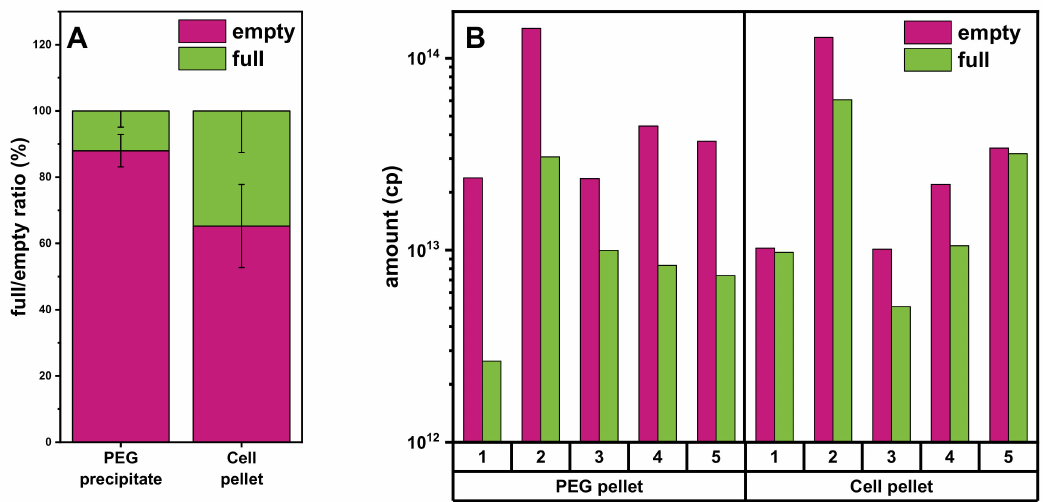
Figure 6. Assessment of the full/empty ratios from the PEG precipitate or cell lysate using analytical AEX chromatography. ( A ) Graph showing the full rAAV (light green) and empty capsid (purple) titer ratio determined using analytical AEX combined with a fluorescence detector. ( B ) Graph depicting the total amount of empty or full capsid values of 5 individual batches obtained from the PEG precipitate or from the cell pellet lysate. PEG, polyethylene glycol.